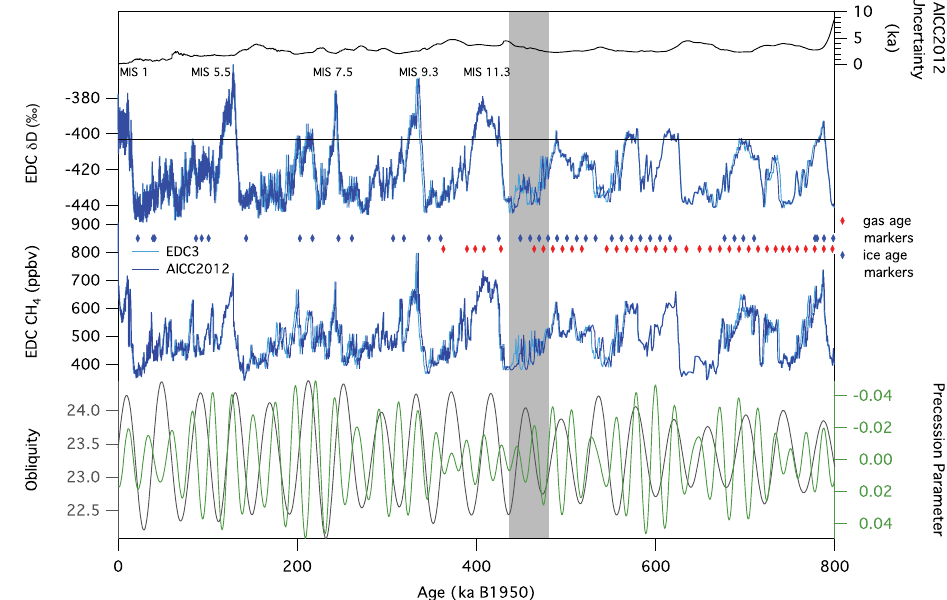
Fig. 6. Top: EDC AICC2012 chronology uncertainty. EDC deuterium records (EPICA Community Members, 2004) over the last 800ka on the EDC3 (light blue) and AICC2012 (dark blue) age scales. The horizontal line corresponds to − 403‰ and limits the interglacial periods (EPICA Community Members, 2004). The position of the orbital markers is shown in the gas (red markers) and ice (blue markers). Middle: CH 4 records of EDC (Loulergue et al., 2008) on EDC3 (light blue) and AICC2012 (dark blue). Bottom: obliquity (grey) and precession parameter (green) over the last 800ka (same as in Fig. 1). The shaded zone highlights the period of significant differences between the two chronologies.